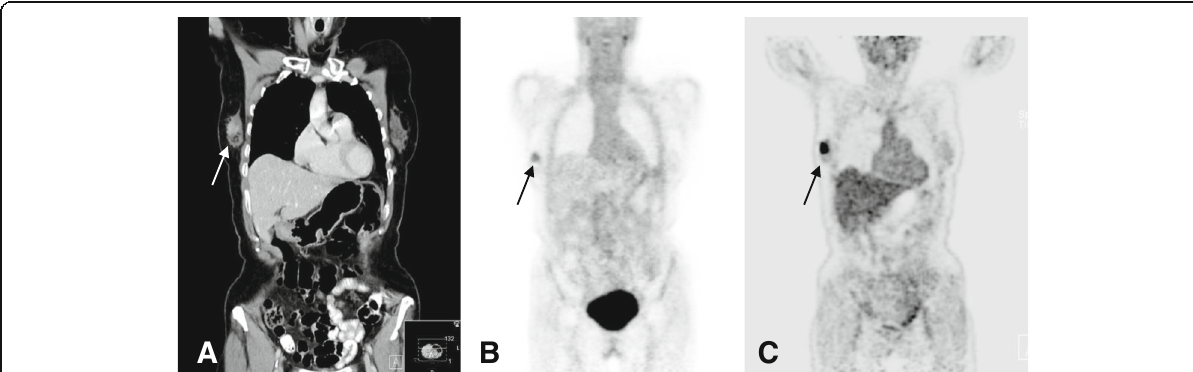
Fig. 1 69-year-old patient with invasive ductal carcinoma (IDC) G2 with primary breast cancer prior to treatment. Coronal CT reconstruction shows contrast enhancement in a lesion with a diameter of 2.2 cm in the right breast ( a ). The tumor is visually detectable on 68 Ga-Pentixafor PET with a corresponding SUVmax of 3.2 ( b ). On 18 F-FDG PET/CT, the lesion demonstrates a significantly higher tracer uptake (SUVmax of 16.5) ( c )